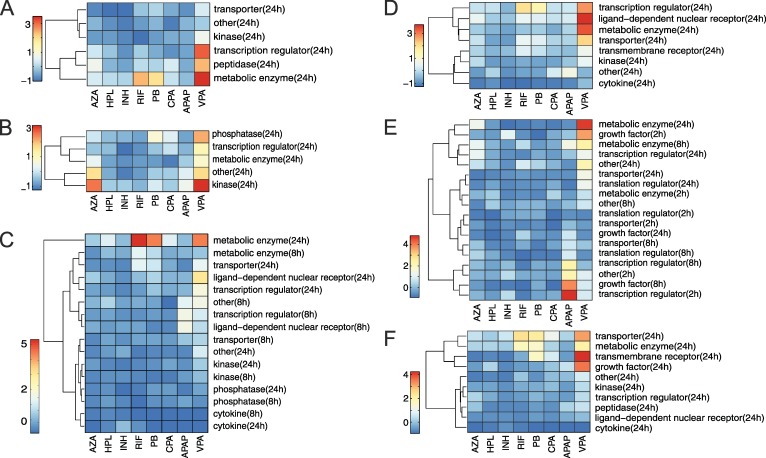
Toxic changes predicted for functional classes of genes involved in key cellular processes.The toxic changes were predicted for different functional classes of genes involved in the respective key cellular processes. All drugs belonging to the high-responsive group were considered. The color scale depicts toxic changes that were normalized over each heatmap. Normalization for each key cellular process is performed by subtracting the mean and by dividing the respective standard deviation.
A‘NRF-2 mediated oxidative stress response’.B‘Cell cycle G2/M DNA damage checkpoint regulation’.C‘PXR/RXR activation’.D‘LPS/IL-1 mediated inhibition of RXR function’.E‘Primary glomerulonephritis biomarker panel’.F‘Aryl hydrocarbon receptor signaling’.